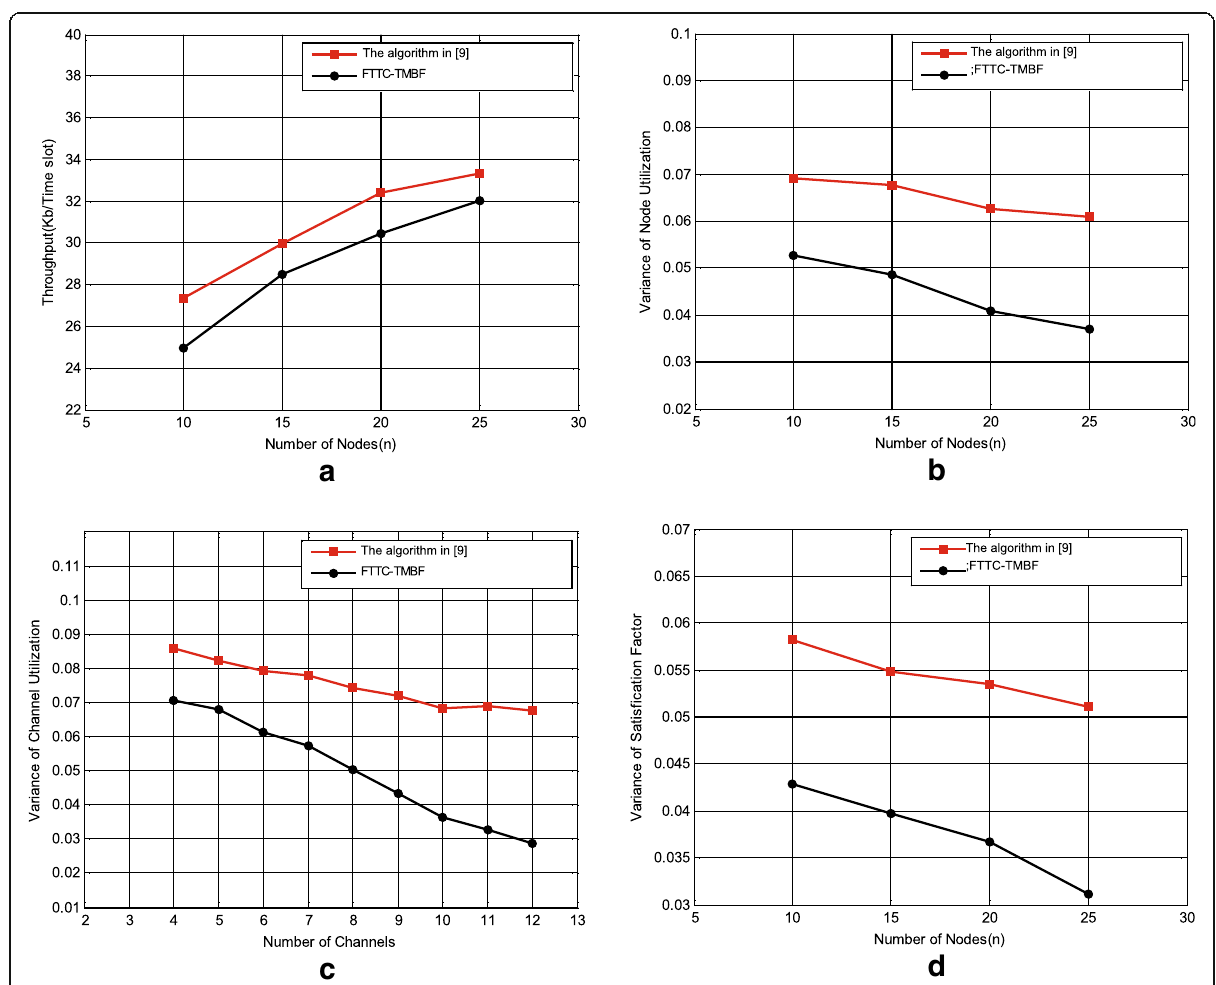
Fig. 4 The comparison of FTTC-TMBF performance and [9] ( a ) throughput ( b ) variance of node utilization ( c ) variance of channel utilization ( d ) variance of satisfaction